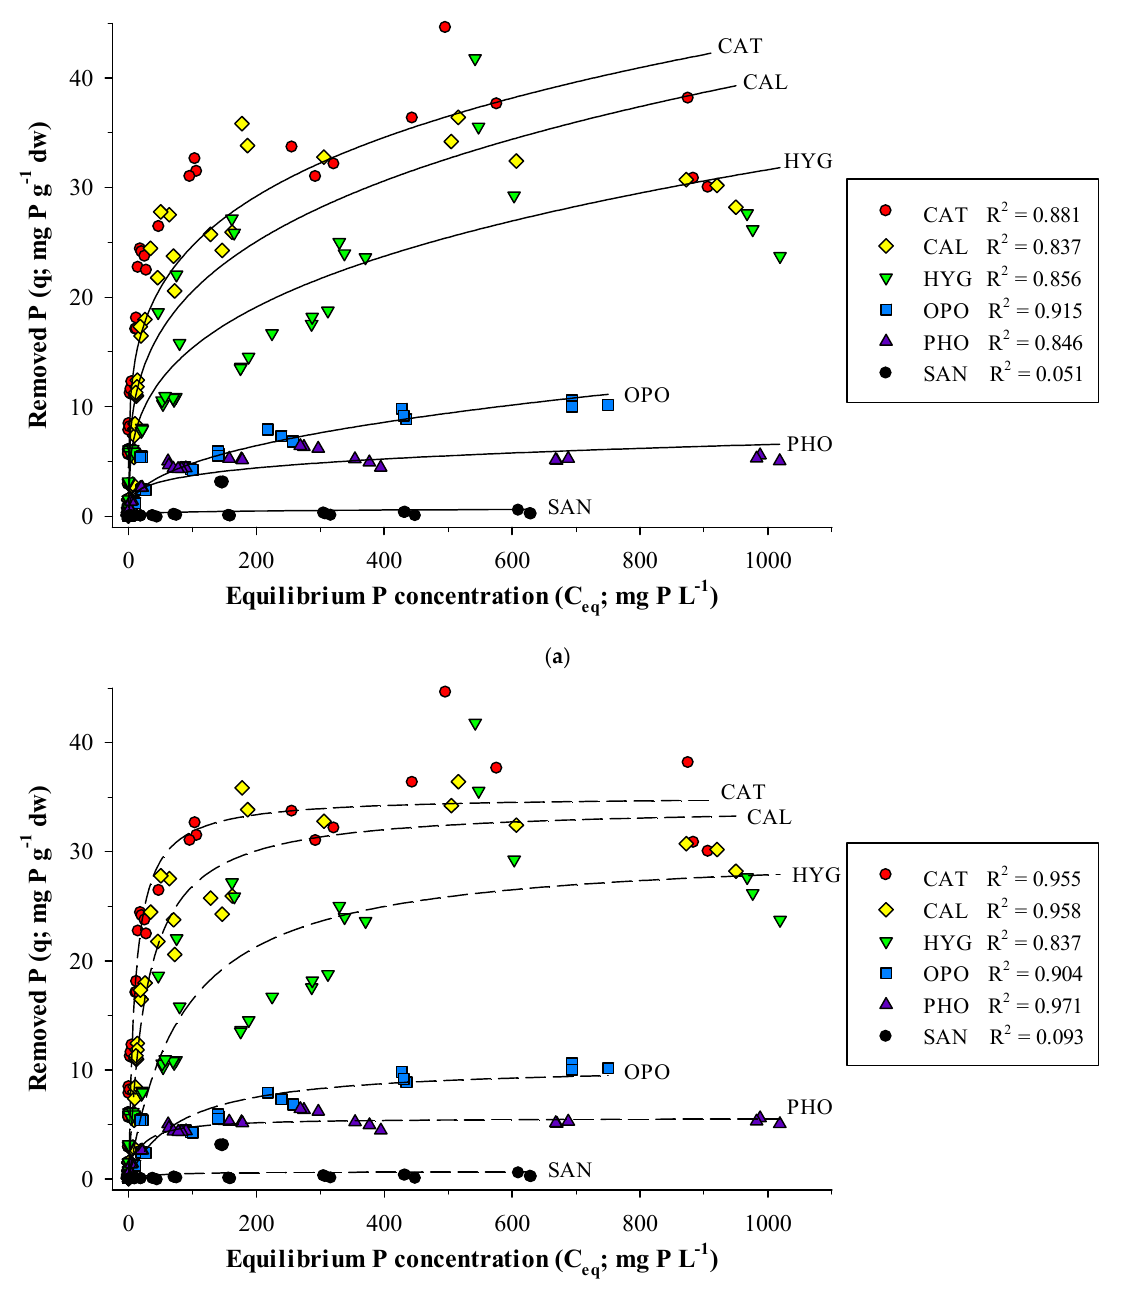
Figure 1. Phosphorus (P) removal isotherms for the non-coated materials, plotting the removed P against the equilibrium P concentration fitted with the ( a ) Freundlich adsorption model ( q = K × C eqn ) and ( b ) Langmuir adsorption model q = ( Q max × a × C eq )/(1 + ( a × C eq )). The initial P concentrations were in the range of 5 to 640–1280 mg L − 1 . The Freundlich adsorption parameters (adsorption constant ( K ) and sorption intensity (1/ n ) and the Langmuir adsorption parameters (the maximum P adsorption capacity ( Q max ) and sorption affinity ( a ) are reported in Table 5. The P removal for the non-coated and coated materials were described using the Freundlich (Equation (2)) and the Langmuir (Equation (1)) models, and the obtained ad- sorption parameters are listed in Table 5.